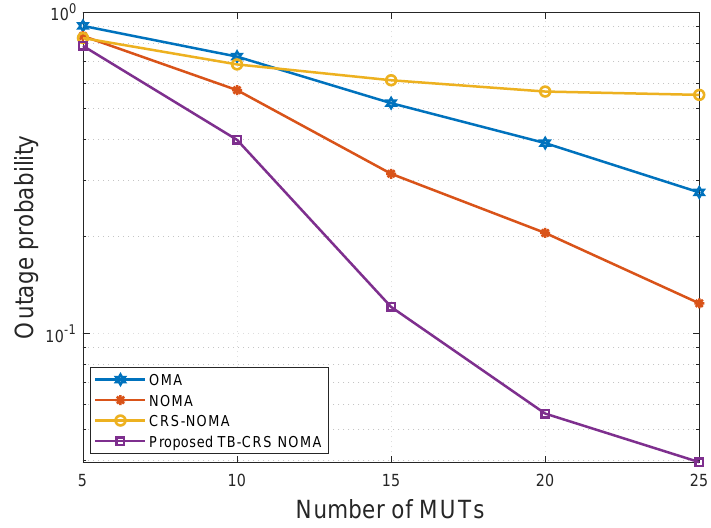
Figure 11. Outage probability versus the number of MUTs when SNR = 20